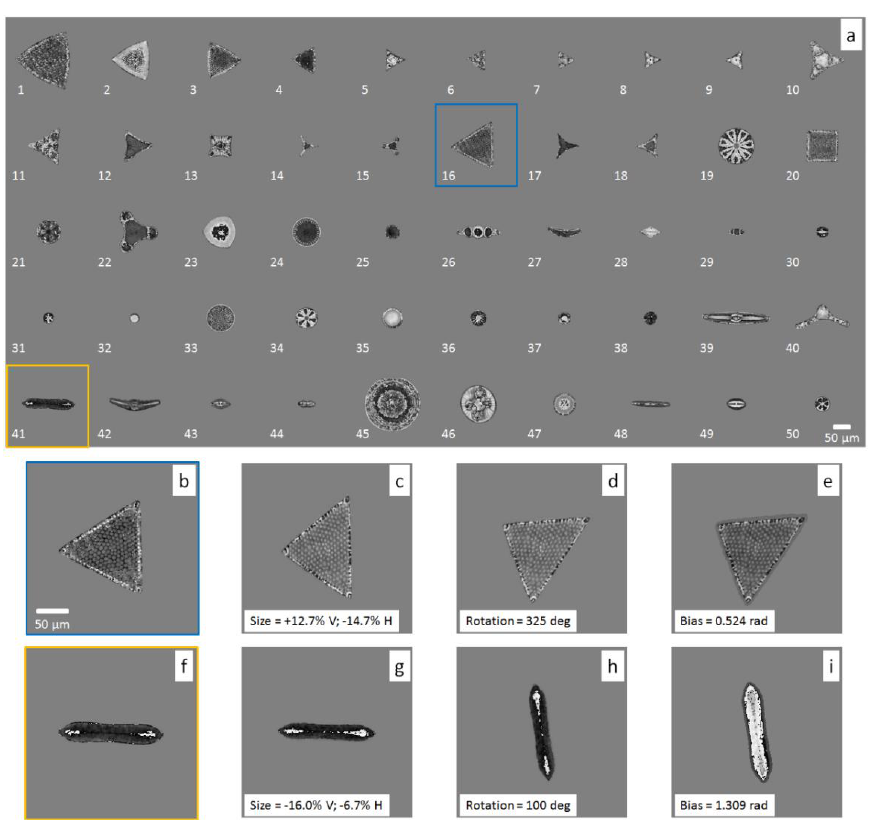
Figure 4. Initial guess for creating the training dataset. ( a ) WQPIs of each diatom in the test glass slide, labeled from 1 to 50. ( b , f ) are two WQPIs selected among the others, on which a cascade of transformations are applied, i.e., resizing ( c , g ), rotation ( d , h ) and phase biasing ( e , i ).